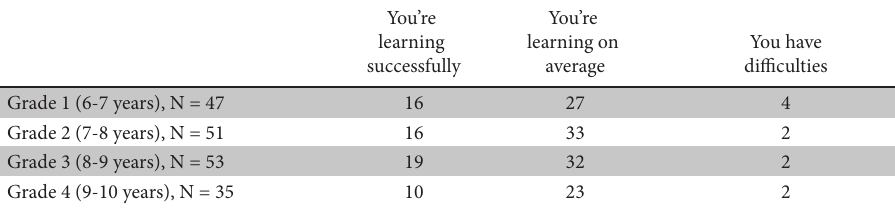
Figure 2: Distribution of pupils’ views on assessing learning achievements (significance level of p � 0 . 01). How do you work in a group? ( Mark the box that works best with a cross +)